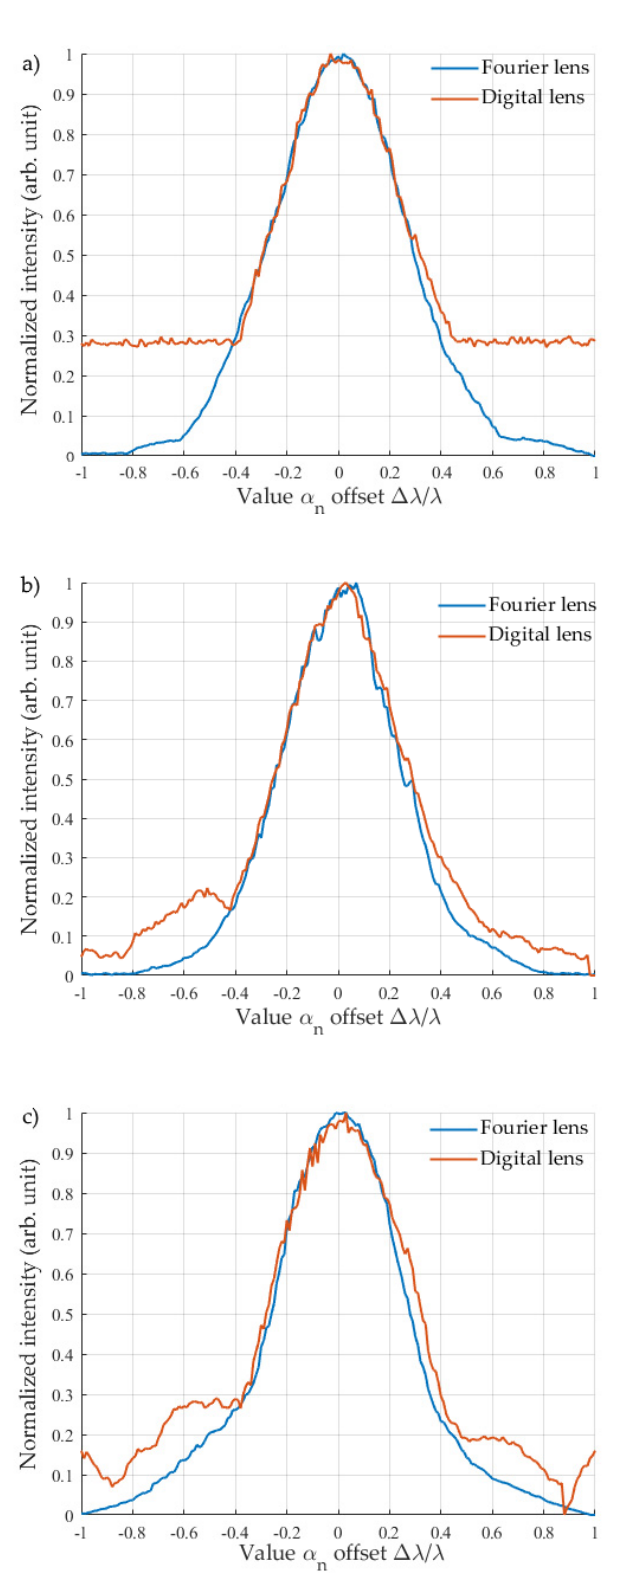
Figure 4. Comparison of the correlation functions obtained via two methods for lenses with a focal length equal to 250 mm ( a ), 500 mm ( b ), and 1000 mm ( c ).